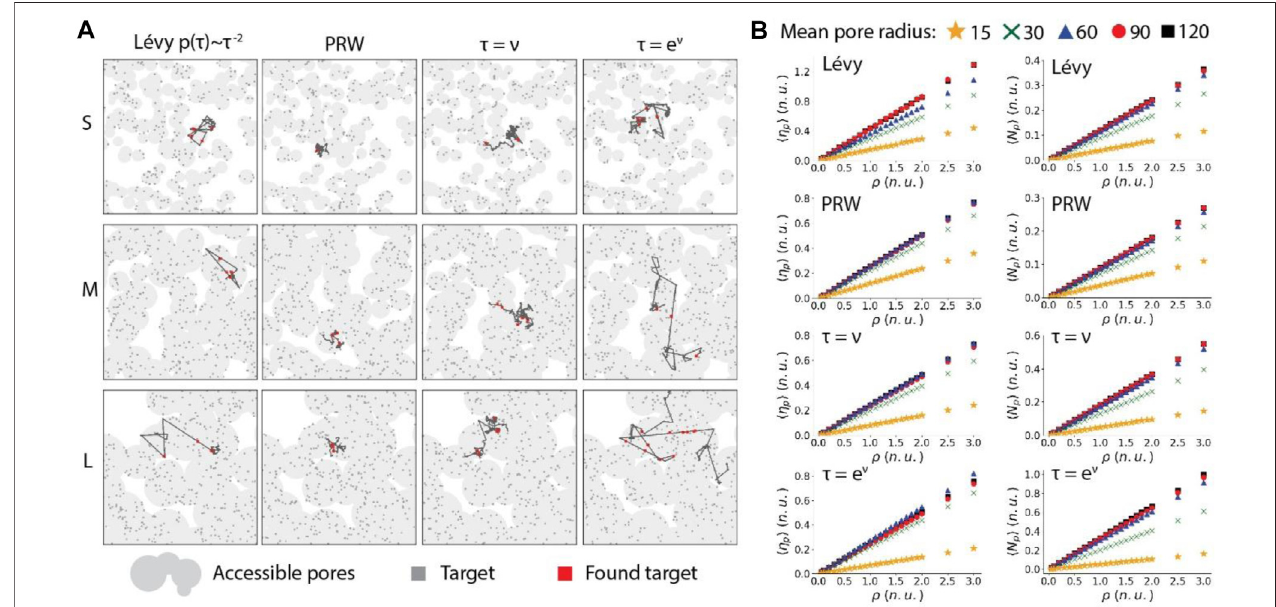
FIGURE8| Thesearchabilityand ef fi ciencyofaparticle in fl uenced bydifferentmoving strategiesintheconcaveporous environments. (A) ,Exampletrajectoriesof Lévy walk, PRW, linear RWSP ( τ (cid:2) v ) and nonlinear RWSP ( τ (cid:2) e v ) in the concave porous media with different pore sizes. S represents small pore size ( r p (cid:2) 30pixels, σ (cid:2) 5pixels), M represents intermediate pore size ( r (cid:2) 60pixels, σ (cid:2) 10pixels), and L represents large pore size ( r (cid:2) 90pixels, σ (cid:2) 15pixels). Light gray areas are p p p p p accessible to the particle and white areas are inaccessible. Gray dots are the targets, and red dots are the targets found by the particle. Dark gray lines are particle trajectories. (B) , The search ability 〈 N p 〉 and ef fi ciency 〈 η p 〉 over target densities ρ in fl uenced by the pore sizes. Dynamics in a convex porous